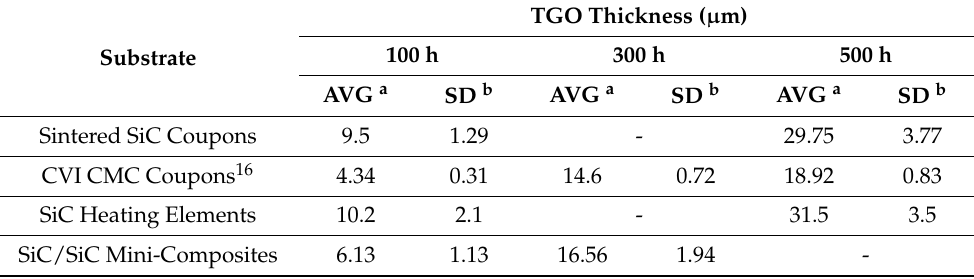
Table 2. TGO Thickness Comparison between Coupons and Sub-Components after Cyclic Steam Oxidation at 1427 ◦ C in 90 vol.% H 2 O + 10 vol.% O 2 .